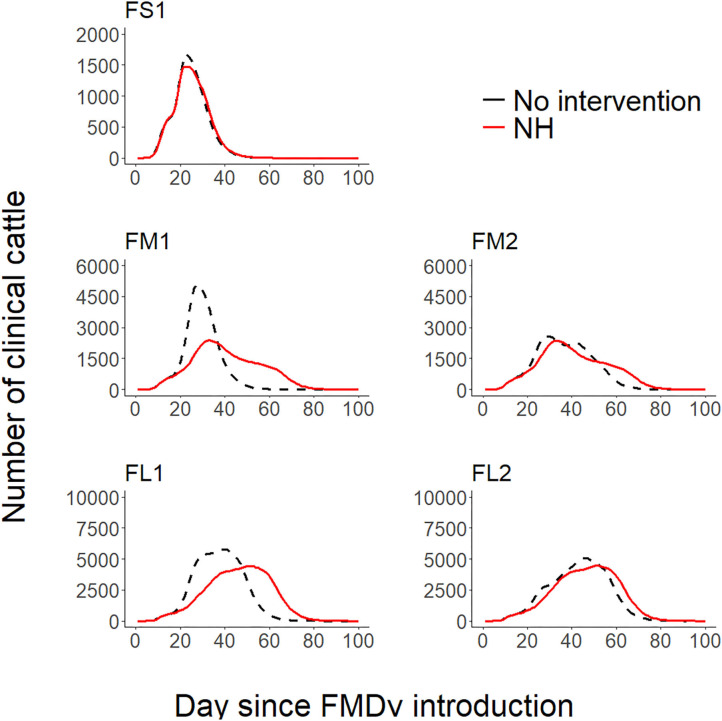
Line plots comparing the projected foot-and-mouth outbreak curves for clinical cattle count (Y-axis) during each day since FMDv introduction (X-axis) between the baseline no intervention scenario (28) and the hospital movement restriction (NH) scenario for each feedlot of size and layout. FS1—small-size feedlot with one hospital-pen, FM1—medium-size feedlot with one hospital-pen, FM2—medium-size feedlot with two hospital-pens, FL1—large-size feedlot with two hospital-pens; and FL2—large-size feedlot with four hospital-pens. The black dashed lines represent the 50th percentile of the distribution of the projected count of clinical cattle across 2,000 simulated outbreaks for the baseline no intervention scenario for each feedlot size and layout (28), red solid lines represent the 50th percentile of the distribution of the projected count of clinical cattle across 2,000 simulated outbreaks for NH—hospital movement restrictions to stop mixing of cattle from different home-pens in the hospital-pen(s) after the day of FMD detection.